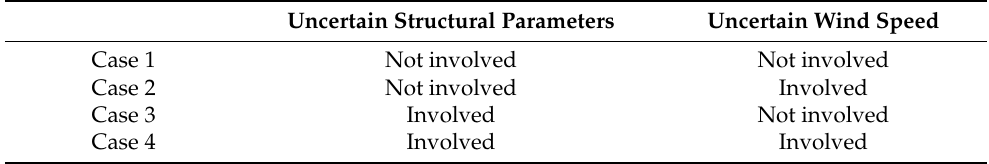
Table 3. The detailed information of numerical cases.